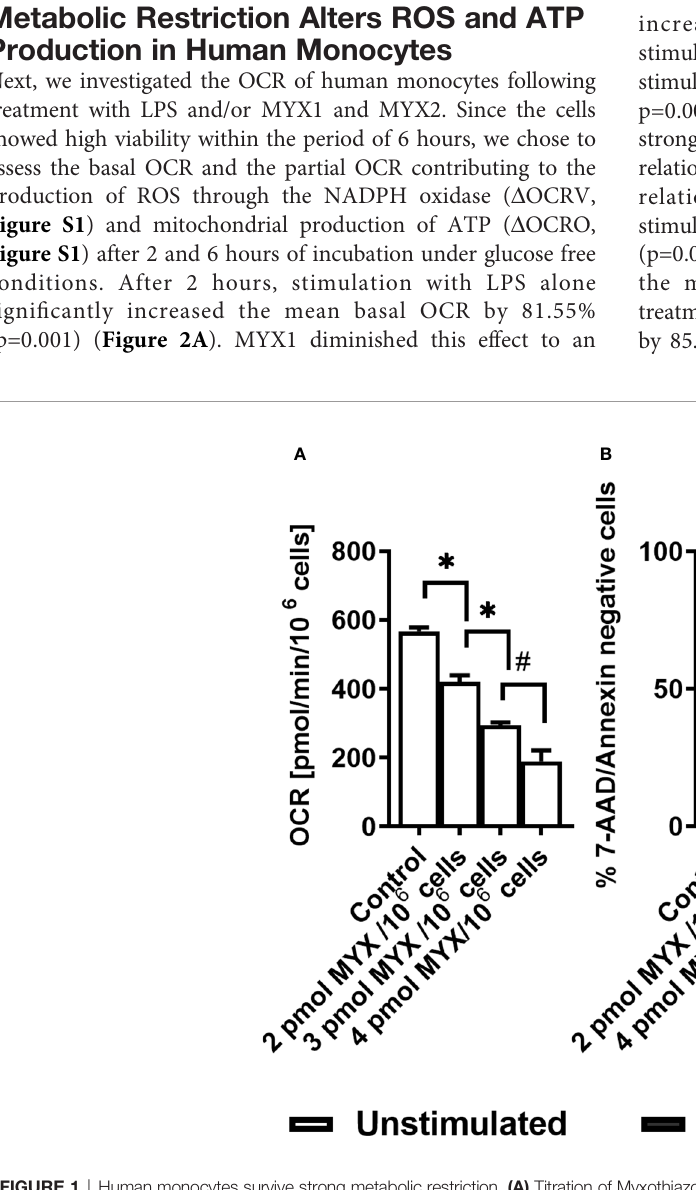
FIGURE 1 | Human monocytes survive strong metabolic restriction. (A) Titration of Myxothiazol (MYX) in medium without glucose in the presence of MYX (pmol/10 6 cells) or 1% (v/v) DMSO (vehicle control) under glucose free conditions (n = 3-6). Values are expressed as mean ± SEM (*p < 0.05 Wilcoxon signed rank test, # p < 0.05 Mann-Whitney U Test). (B) Viability of quiescent and stimulated (100 ng/mL LPS) human monocytes after 6 h of incubation in the presence or absence of MYX (pmol/10 6 cells) or vehicle control (1% (v/v) DMSO) under glucose free conditions (n = 6). Values are expressed as mean ± SEM (*p < 0.05 Wilcoxon signed rank